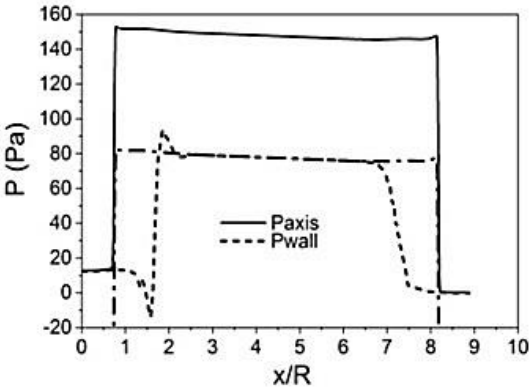
Figure 8. Variation of the wall and axial pressure along the axial length of the channel for u TP =0.0566ms -1 and β=0.735 for the dodecane-water system. (The dashed line represents the axial pressure shifted by Laplace pressure difference, which is equal to 75 Pa